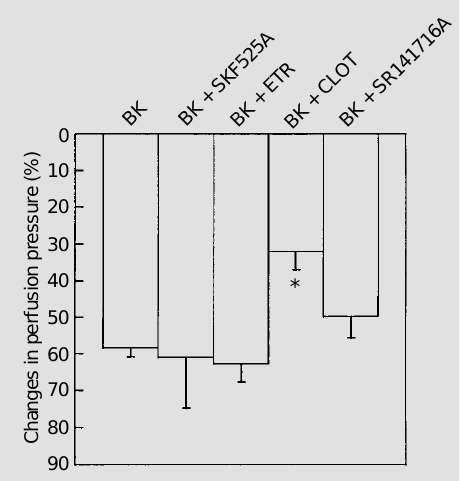
Figure 5 - Vasodilator effect of bradykinin (BK; 40 ng) in the ab- sence or in the presence of the cytochrome P450 enzymes SKF525A (BK + SKF525A; 5 µM), ethoxyresorufin (BK + ETR; 5 µM), clotrimazole (BK + CLOT; 5 µM), or the CB 1 -cannabinoid receptor antagonist SR141716A (BK + SR141716A; 1 µM). Val- ues (mean ± SEM) represent the percent decrease in mesenteric perfusion pressure (N = 4-6). *P<0.05 vs BK (Student t